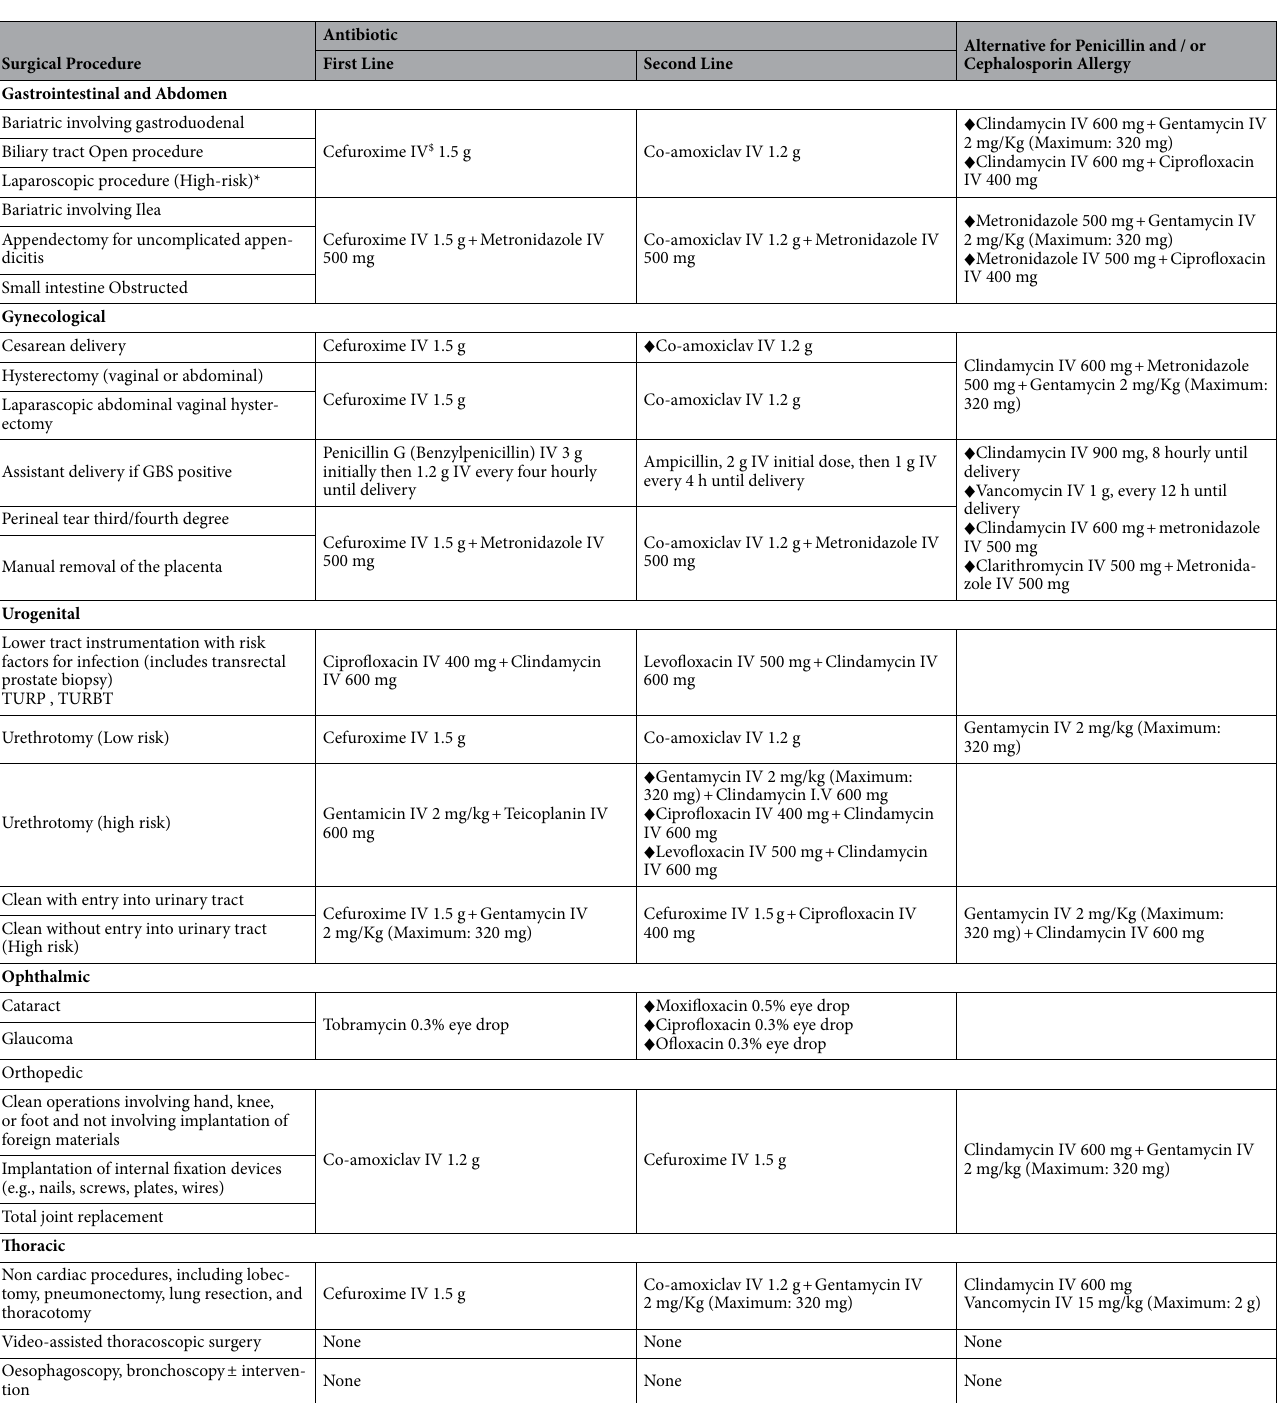
Table 1. Preoperative antibiotics prophylaxis for the most commonly performed surgical procedures. $ Intravenous route of administration. *Emergency procedures, diabetes, long procedure duration, intraoperative gallbladder rupture, age of > 70 years, conversion from laparoscopic to open cholecystectomy, American Society of Anesthesiologists classification of 3 or greater, episode of colic within 30 days before the procedure, intervention in less than one month for noninfectious complication, acute cholecystitis, bile spillage, jaundice, pregnancy, nonfunctioning gallbladder, immunosuppression, and insertion of prosthetic